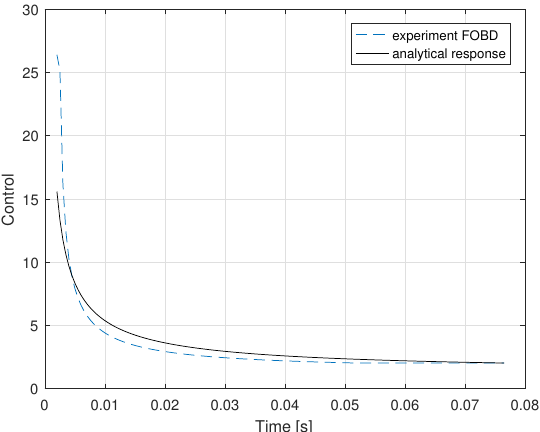
Figure 6. The step-response of FOPID using FOBD vs. the analytical response for α = 0.75, β = 0.75. IAE = 0.0588, and ISE =